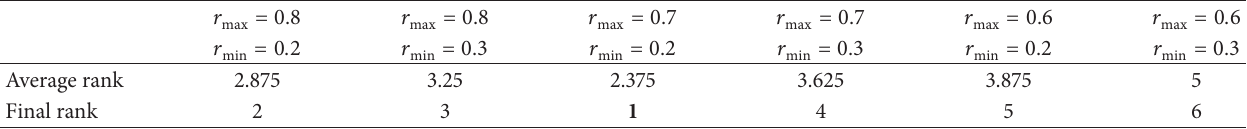
Table 2: Rank results of the different combinations of 𝑟 max and 𝑟 min in